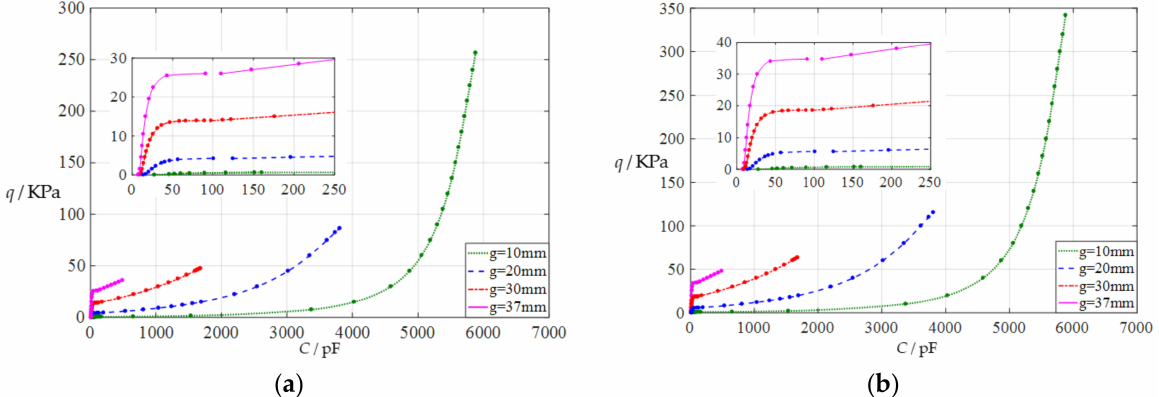
Figure 5. The capacitance-pressure relationships of a circular capacitive pressure sensor from non-touch mode of operation to touch mode of operation: ( a ) for a = 100 mm, h = 1.5 mm, t = 0.1 mm, E = 7.84 MPa, ν = 0.47, and g = 10 mm, 20 mm, 30 mm, and 37 mm; ( b ) for a = 100 mm, h = 2 mm, t = 0.1 mm, E = 7.84 MPa, ν = 0.47, and g = 10 mm, 20 mm, 30 mm, and 37